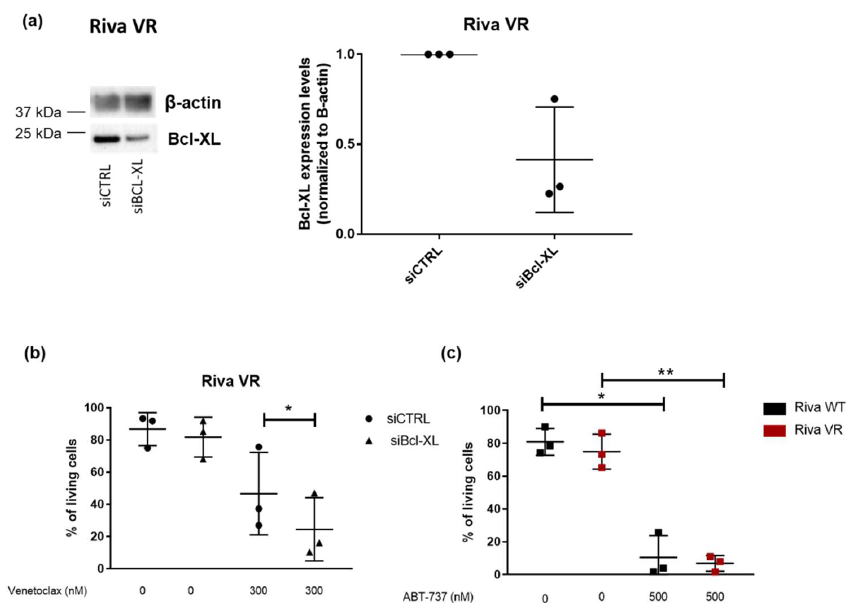
Figure 5. Bcl-XL knockdown sensitizes Riva VR cells to venetoclax. ( a ) Left: representative Western blots of Bcl-XL-expression levels in Riva VR cells after treatment with siCTRL or siBcl-XL. β-actin was used as a loading control. Right: quantification of Bcl-XL-expression levels. Expression levels in Riva VR were normalized to the Bcl-XL levels in siCTRL-treated cells, which were set at 1. Data are represented as the average ± SD ( n = 3). ( b ) Flow cytometric analysis of AnnexinV-FITC negative and 7-AAD negative cells treated with venetoclax for 24 h. Data are ± SD (N = 3); * p < 0.05. ( c ) Flow cytometric analysis of AnnexinV-FITC negative and 7-AAD negative Riva WT and VR cells treated with ABT-737 for 24 h. Data are ± SD ( n = 3); * p < 0.05, ** p < 0.01.